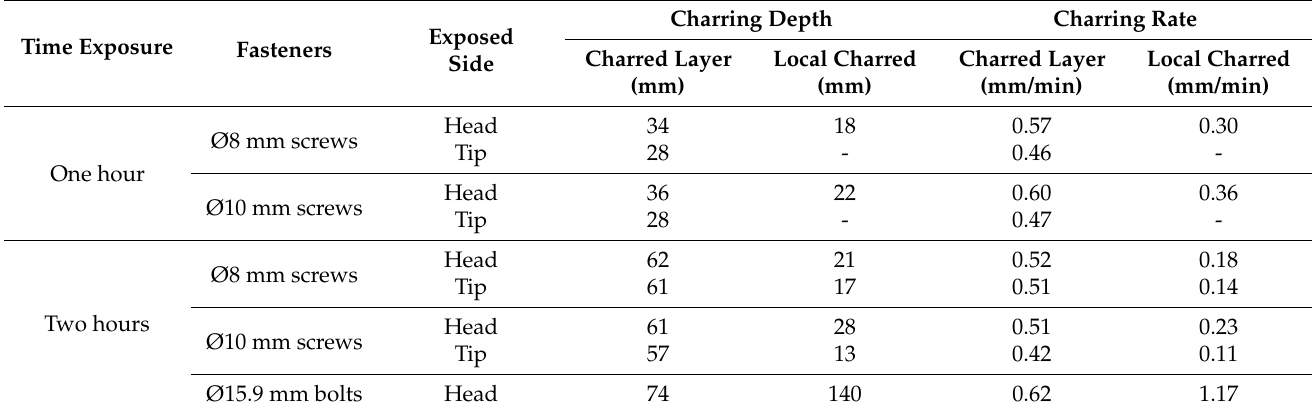
Table 3. Average values of charring depth and charring rate for all the tests exposed to a constant heat flux.